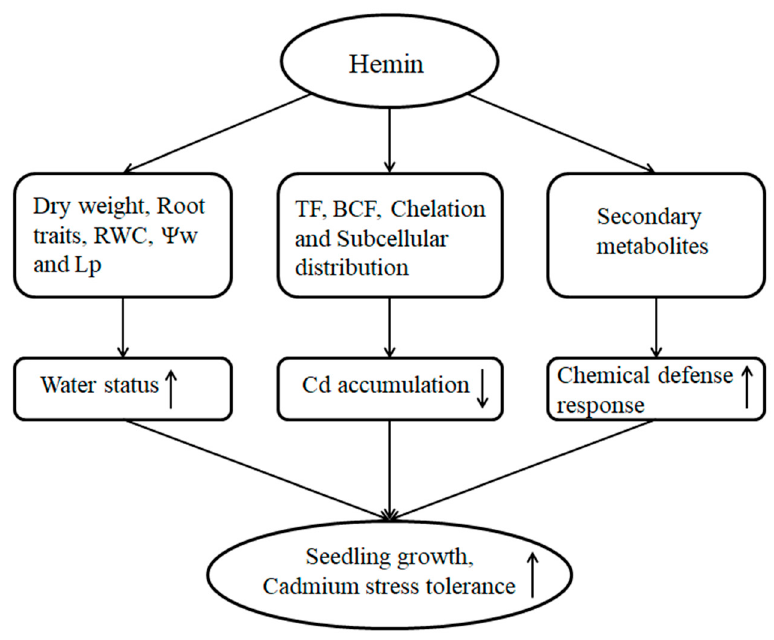
Figure 1. Schematic representation of the positive role of hemin on tolerance of maize to Cd stress. A model was developed to show that water status, Cd concentration, and chemical defense response were regulated by hemin in maize under Cd stress. The arrows ( ↑ ) and ( ↓ ) represent the positive and passive roles of hemin, respectively.